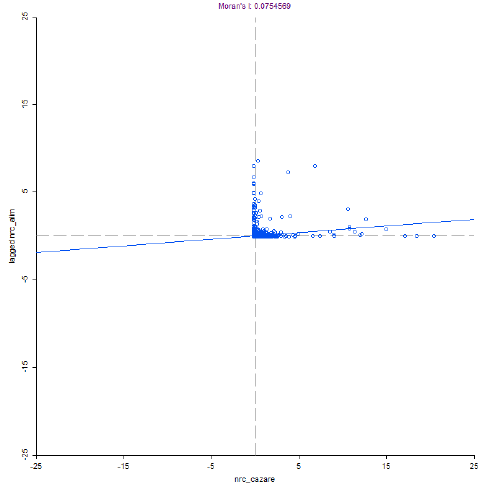
Figure 8: Moran’s scatter plot for bivariate spatial correlation between the number of accommodation companies and the number of foodservice companies